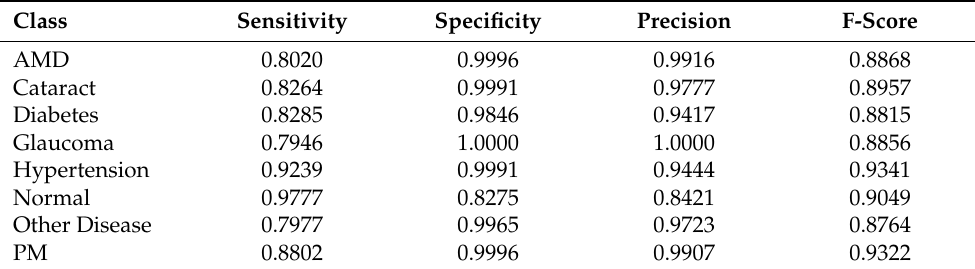
Table 2. The other performance results of the proposed approach.